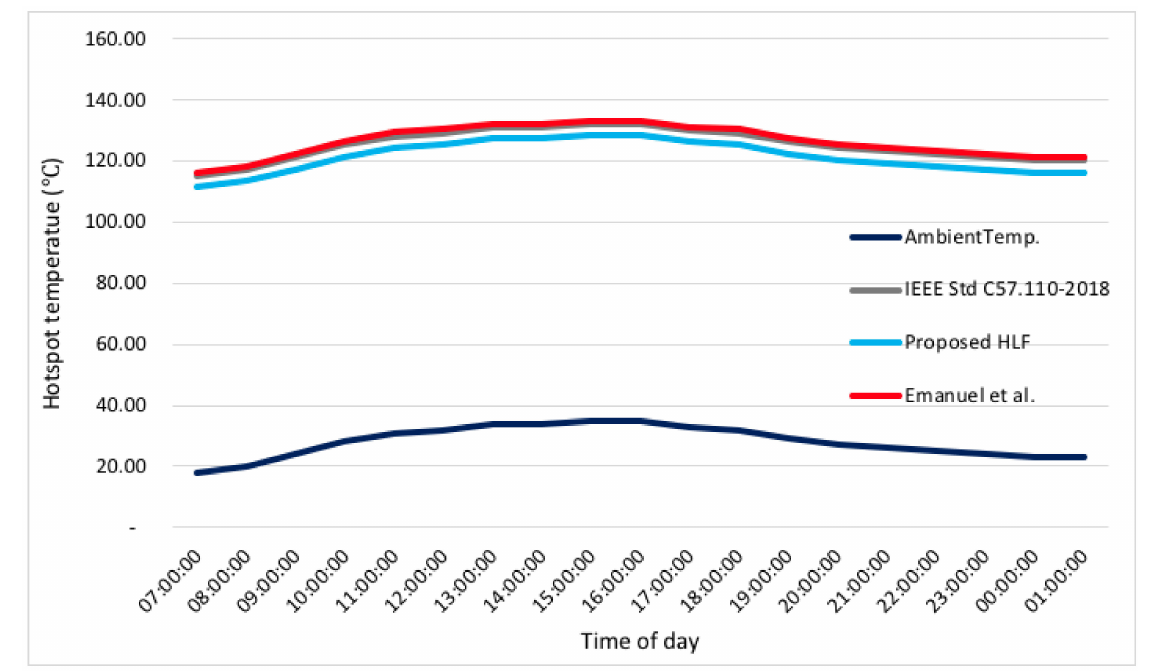
Figure 10. Hourly hotspot temperature variation, 5000 kVA 33/0.42 kV